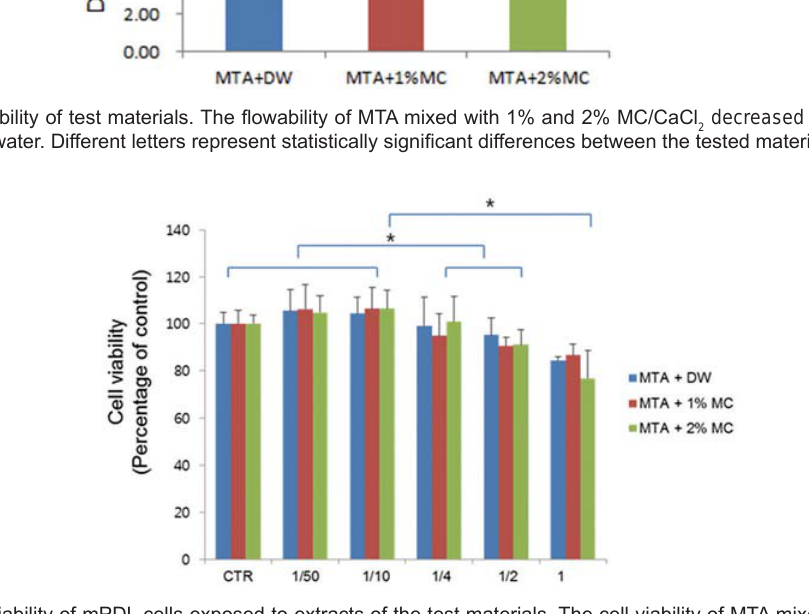
Figure 2- (cid:3)(cid:55)(cid:75)(cid:72)(cid:3)(cid:70)(cid:72)(cid:79)(cid:79)(cid:3)(cid:89)(cid:76)(cid:68)(cid:69)(cid:76)(cid:79)(cid:76)(cid:87)(cid:92)(cid:3)(cid:82)(cid:73)(cid:3)(cid:80)(cid:51)(cid:39)(cid:47)(cid:3)(cid:70)(cid:72)(cid:79)(cid:79)(cid:86)(cid:3)(cid:72)(cid:91)(cid:83)(cid:82)(cid:86)(cid:72)(cid:71)(cid:3)(cid:87)(cid:82)(cid:3)(cid:72)(cid:91)(cid:87)(cid:85)(cid:68)(cid:70)(cid:87)(cid:86)(cid:3)(cid:82)(cid:73)(cid:3)(cid:87)(cid:75)(cid:72)(cid:3)(cid:87)(cid:72)(cid:86)(cid:87)(cid:3)(cid:80)(cid:68)(cid:87)(cid:72)(cid:85)(cid:76)(cid:68)(cid:79)(cid:86)(cid:17)(cid:3)(cid:55)(cid:75)(cid:72)(cid:3)(cid:70)(cid:72)(cid:79)(cid:79)(cid:3)(cid:89)(cid:76)(cid:68)(cid:69)(cid:76)(cid:79)(cid:76)(cid:87)(cid:92)(cid:3)(cid:82)(cid:73)(cid:3)(cid:48)(cid:55)(cid:36)(cid:3)(cid:80)(cid:76)(cid:91)(cid:72)(cid:71)(cid:3)(cid:90)(cid:76)(cid:87)(cid:75)(cid:3)(cid:20)(cid:8)(cid:3)(cid:68)(cid:81)(cid:71)(cid:3)(cid:21)(cid:8)(cid:3)(cid:48)(cid:38)(cid:18)